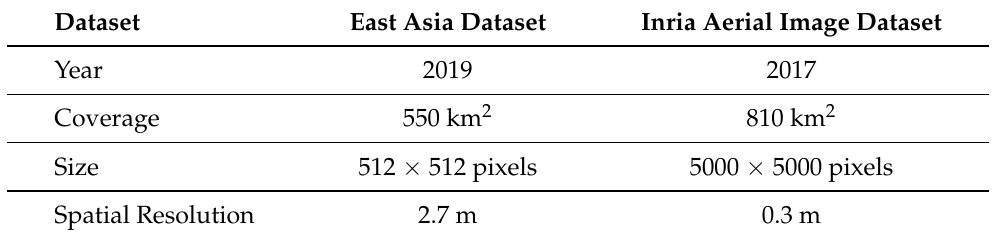
Table 1. The detailed information of the two building detection